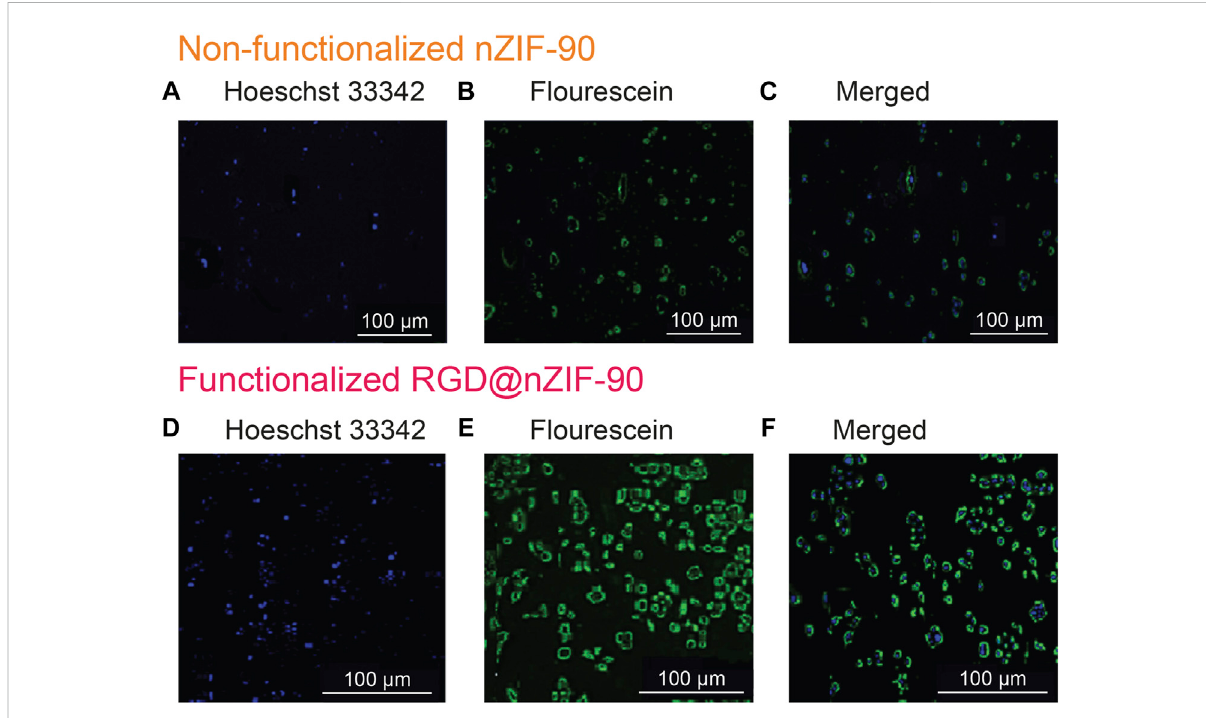
FIGURE 4 Differential cellular uptake of nanoparticles in A549 cells with fl uorescence microscopy images showing nanoparticles localized in different cellular compartments: for the non- fi ctionalized FI ⊂ nZIF-90, (A) Hoechst 3342, (B) Fluorescein, (C) merged images and for the RGD-functionalized RGD@FI ⊂ nZIF-90, (D) Hoechst 3342, (E) Fluorescein, and (F) merged